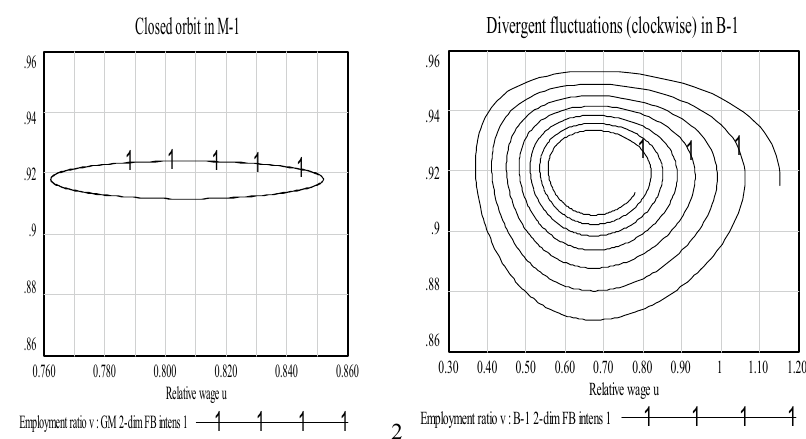
Fig. 4 A centre in M-1 (panel 1) and unstable focus in B-1 (panel 2): relative wage u vs employment ratio v , years